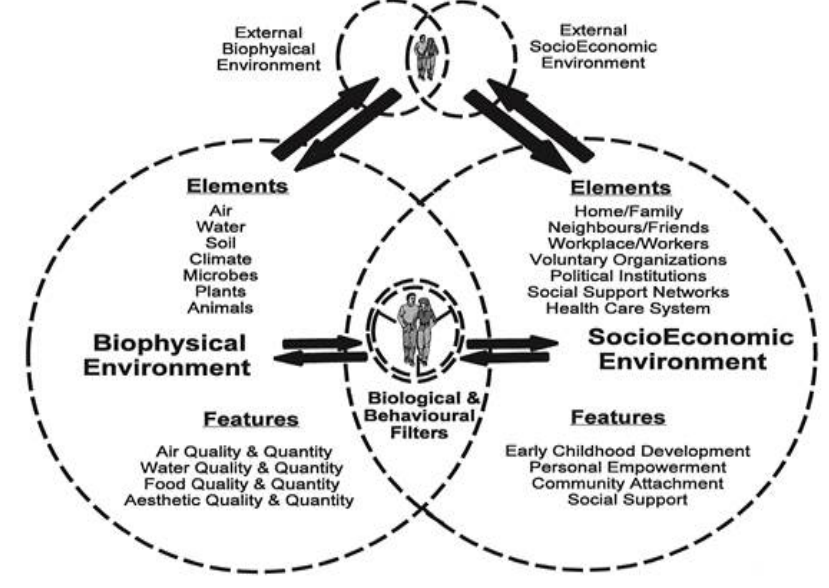
Figure 3. The Butterfly Model of Health (reprinted from [15] with permission from John A. Burns School of Medicine, University of